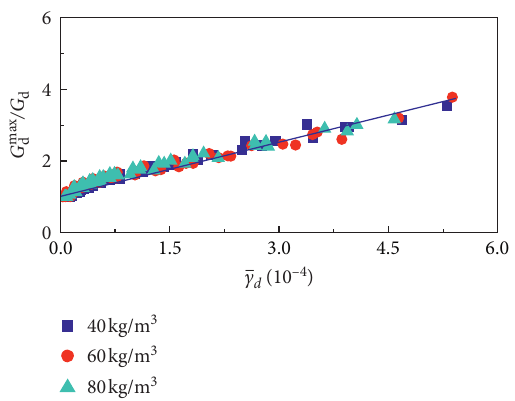
/ G and c with varying d d d